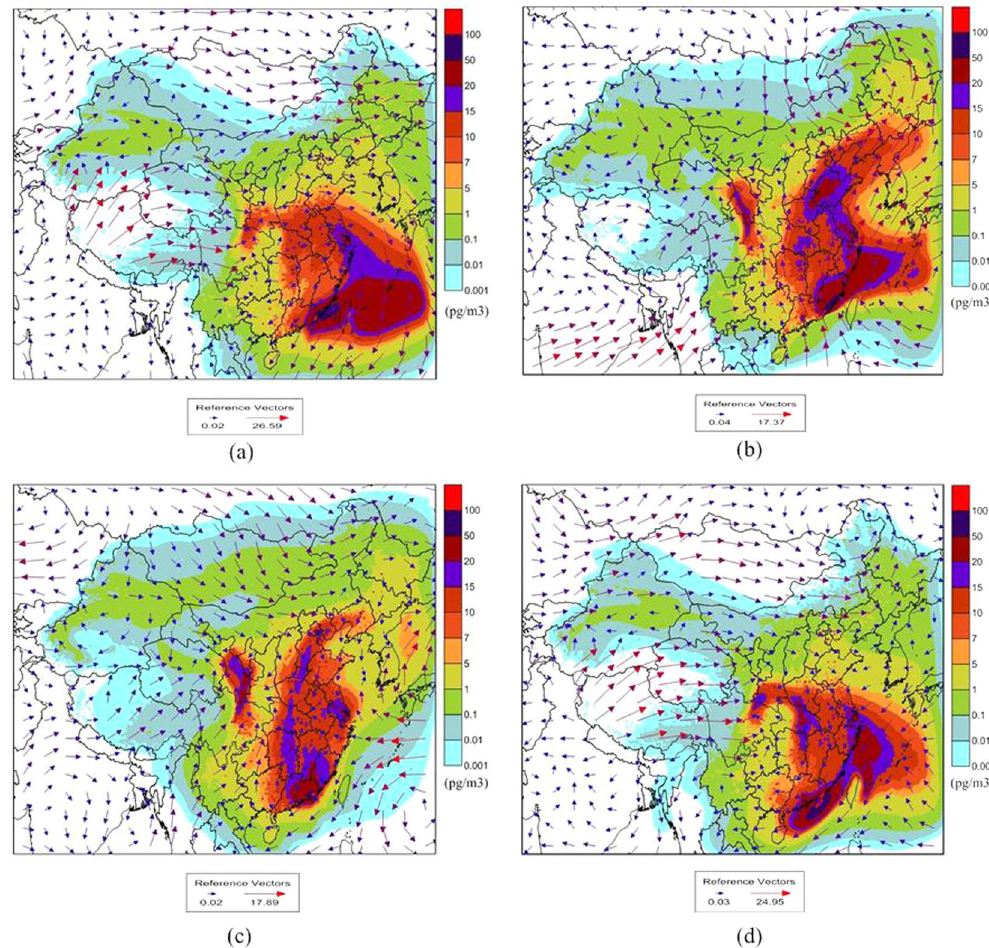
Figure 3. Air concentration of PCB28 in 2005: ( a ) January to March, ( b ) April to June, ( c ) July to September, and ( d ) October to December. The maps were drawn by the software of Surfer 9.0, http://www.goldensoftware.